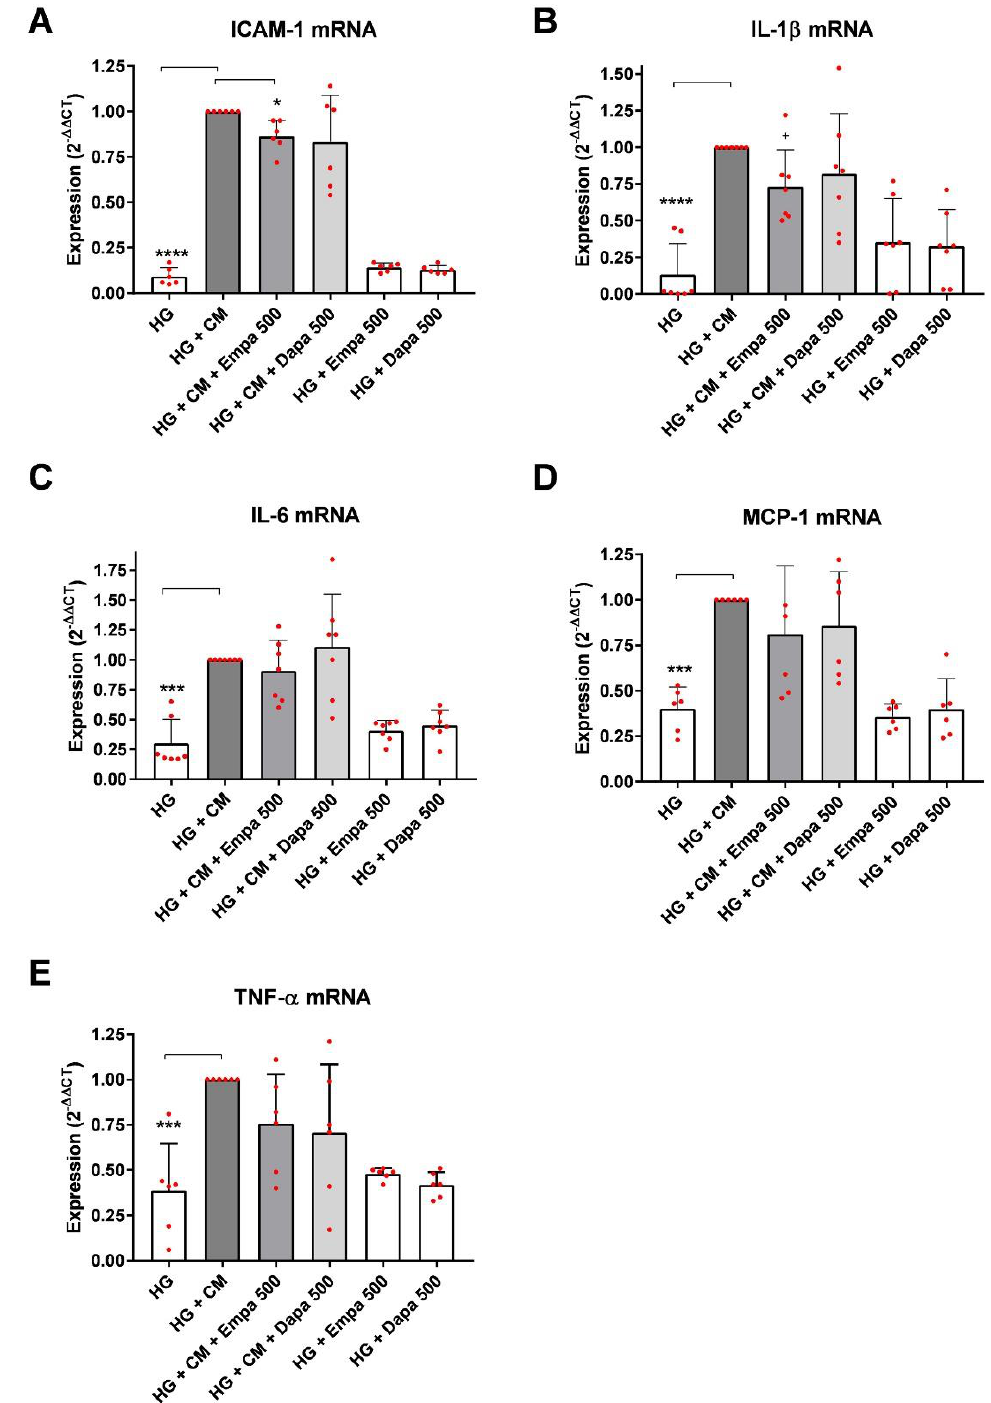
Figure 3. Effect of empagliflozin and dapagliflozin on mRNA expression of selected factors under diabetic and inflammatory culture conditions, ( A ) ICAM-1, ( B ) IL-1 β , ( C ) IL-6, ( D ) MCP-1, ( E ) TNF- α . Cells were grown in small culture flasks until confluence, serum depleted for 2 h, and cultured as indicated for 24 h. The expression levels in each experiment were normalized to a housekeeping gene ( β -actin) and expressed relative to the control using the ∆∆ CT method. A mixture of pro-inflammatory cytokines (CM) significantly increased the mRNA expression of all five readouts after 24 h incubation. Scatter plots with bar, mean ± SD, **** p < 0.0001 ( A , B ), *** p < 0.001 ( C – E ), * = 0.0217 ( A ), + = 0.0519 ( B ), n = 6 – 7.